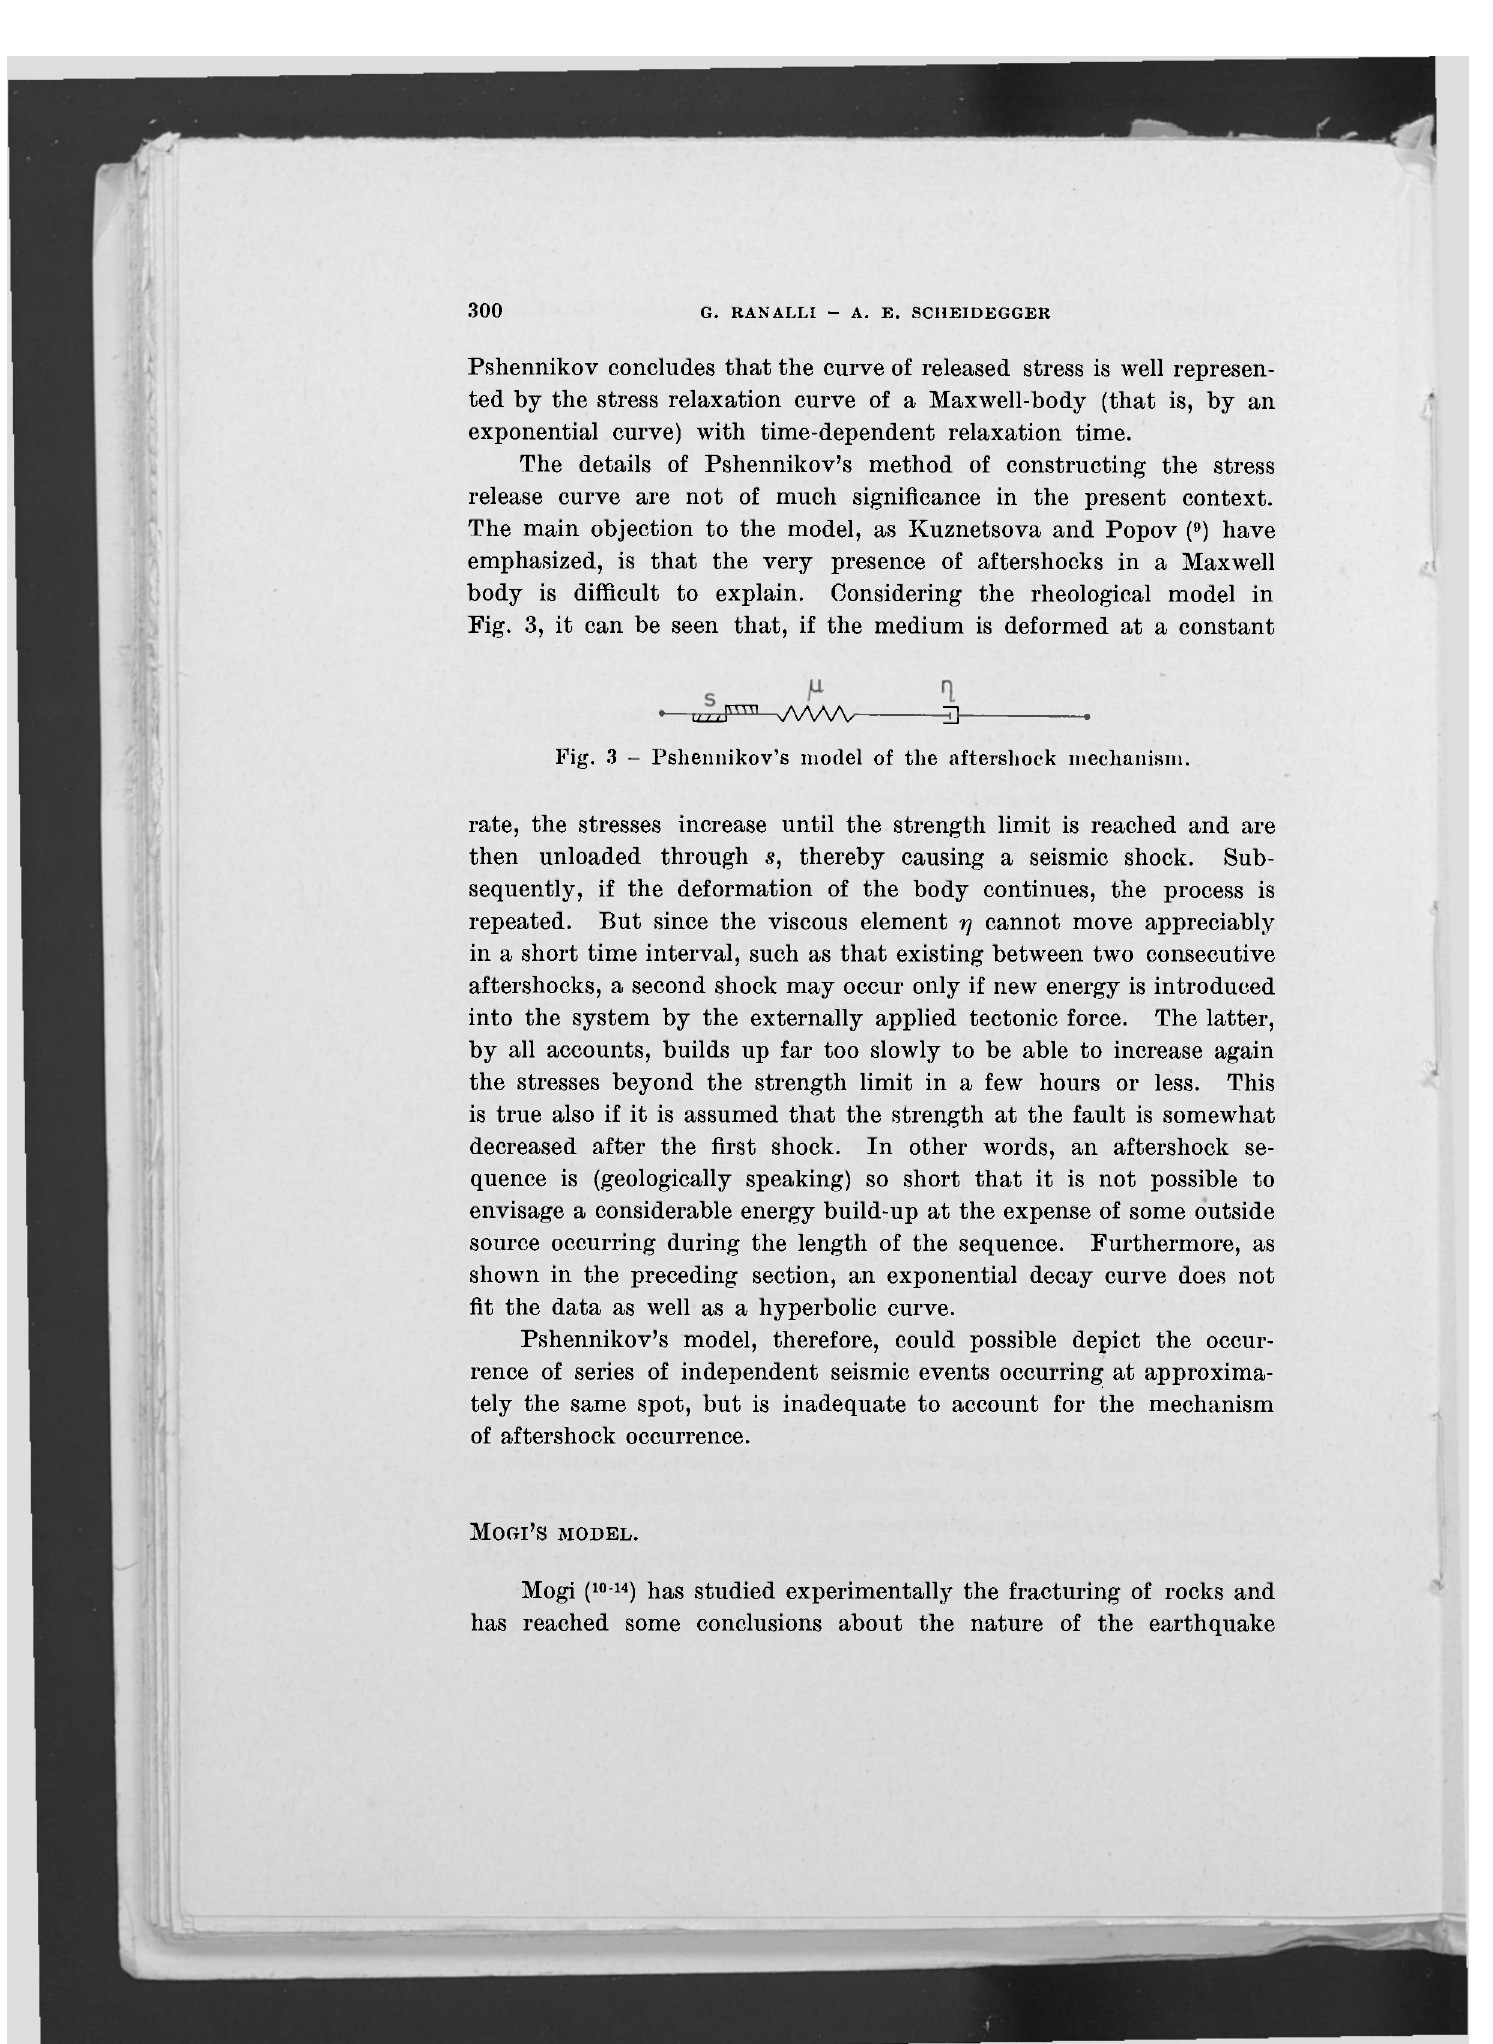
Fig. 3 - Pshennikov's model of the aftershock